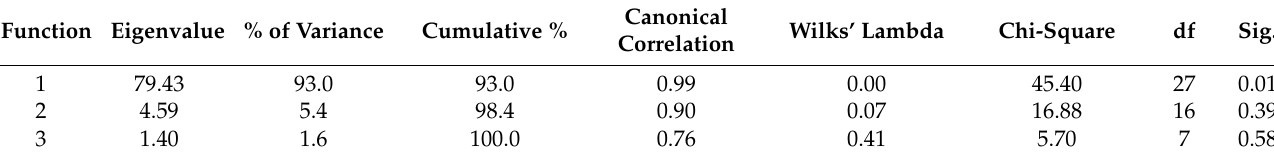
Table 4. Fisher discriminant analysis